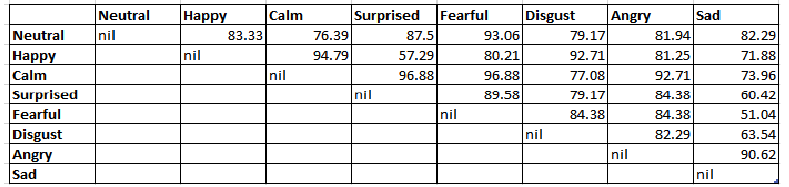
Table 1. Accuracies between pairs of emotions before using the spectral contrast feature